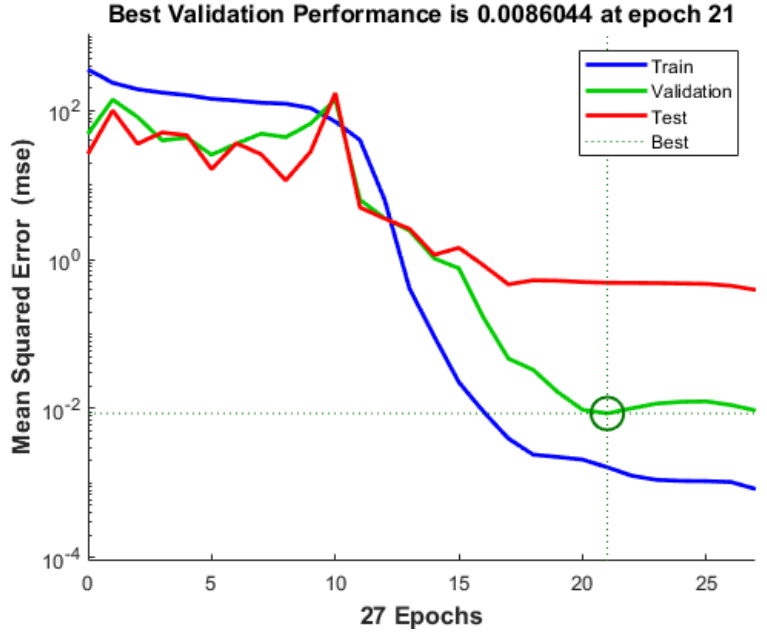
Figure 26. Performance of neural model identification.